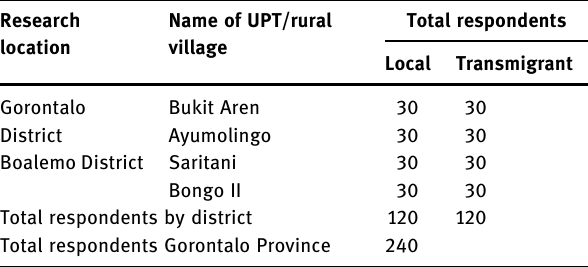
Table 1: Number of respondents selected in this study Research